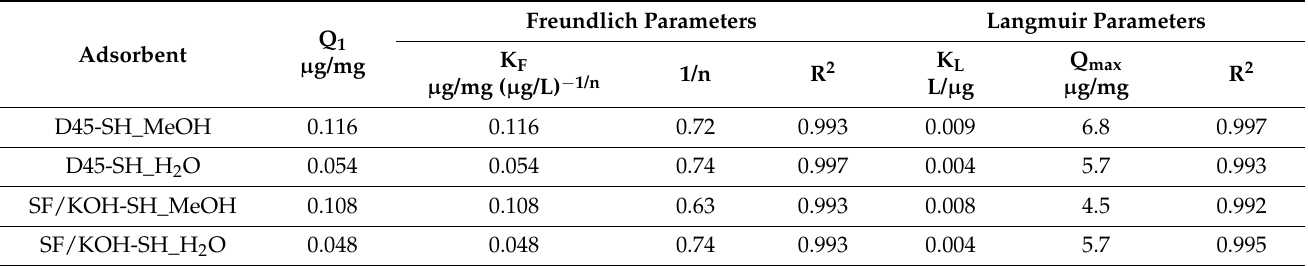
Table 3. Estimated fitting parameters of Freundlich and Langmuir main adsorption